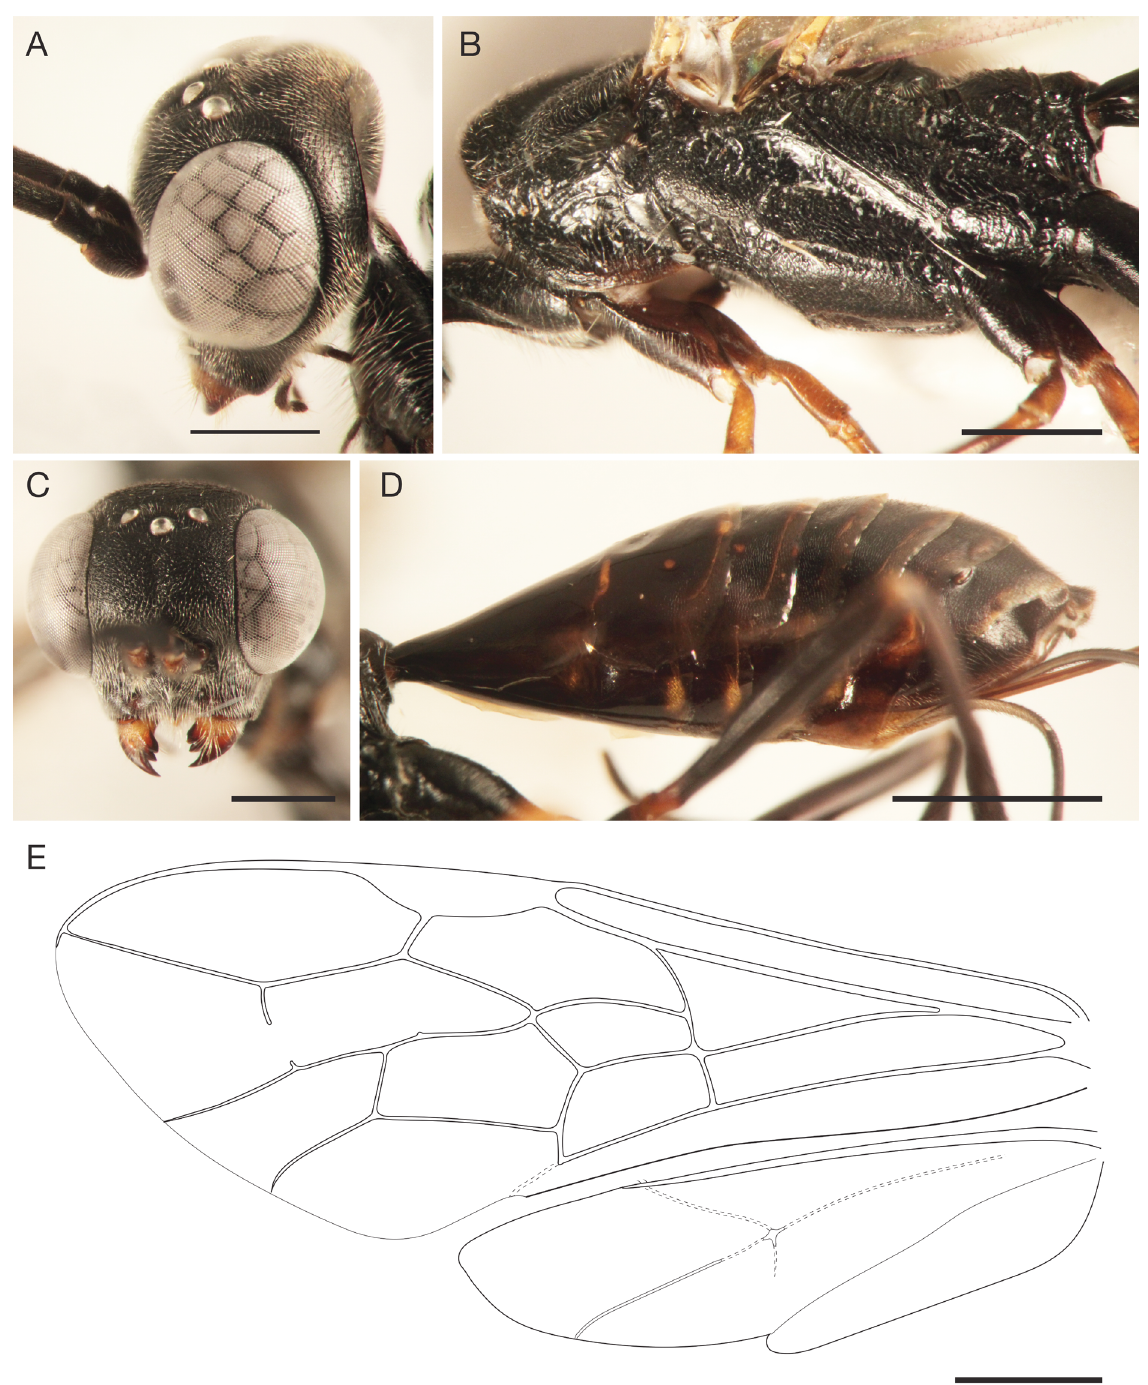
Fig. 5. Pristaulacus villemantae sp. nov., holotype, ♀ (MNHN). A . Head in lateral view. B . Mesosoma in lateral view. C . Head in full-face view. D . Metasoma in lateral view. E . Line drawing of wings venation. Scale bars: A–C = 0.5 mm; D–E =